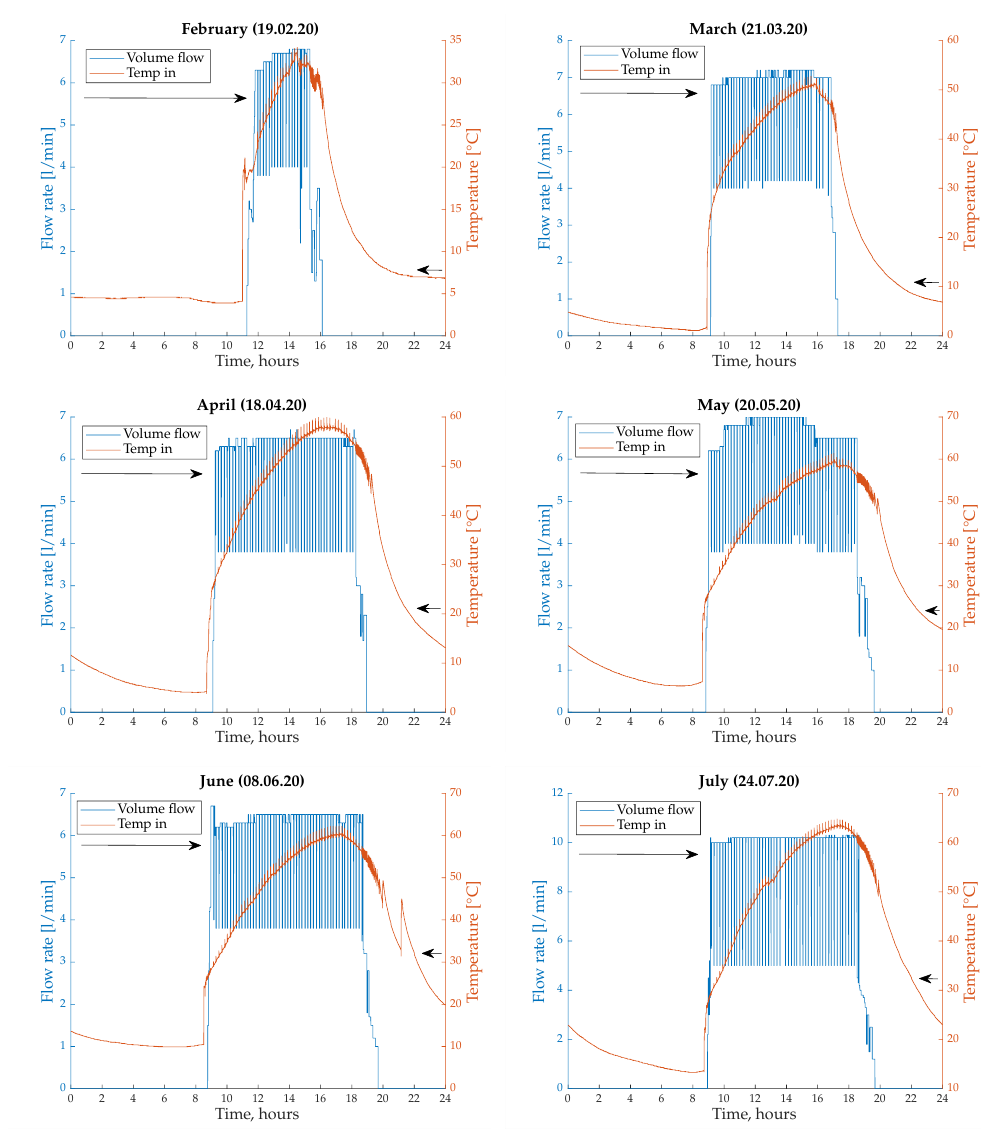
Figure 5. Examples of collector logs for 6 selected dates in February–July.